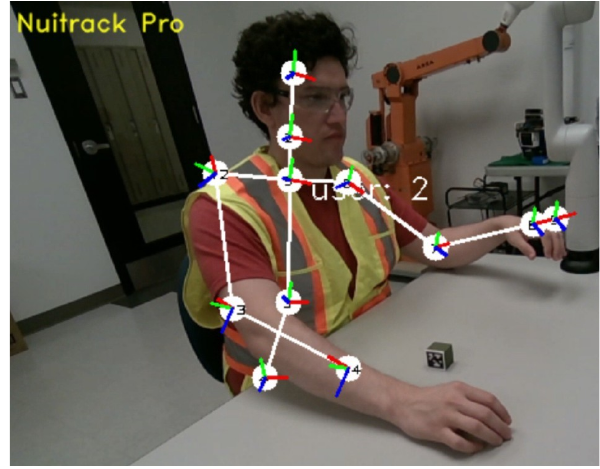
Figure 7. View from the Nuitrack application showing the user’s skeleton as detected by the software. Our solution extracts the joints and transfers their locations in the manipulator reference frame to generate obstacles for the path planner.